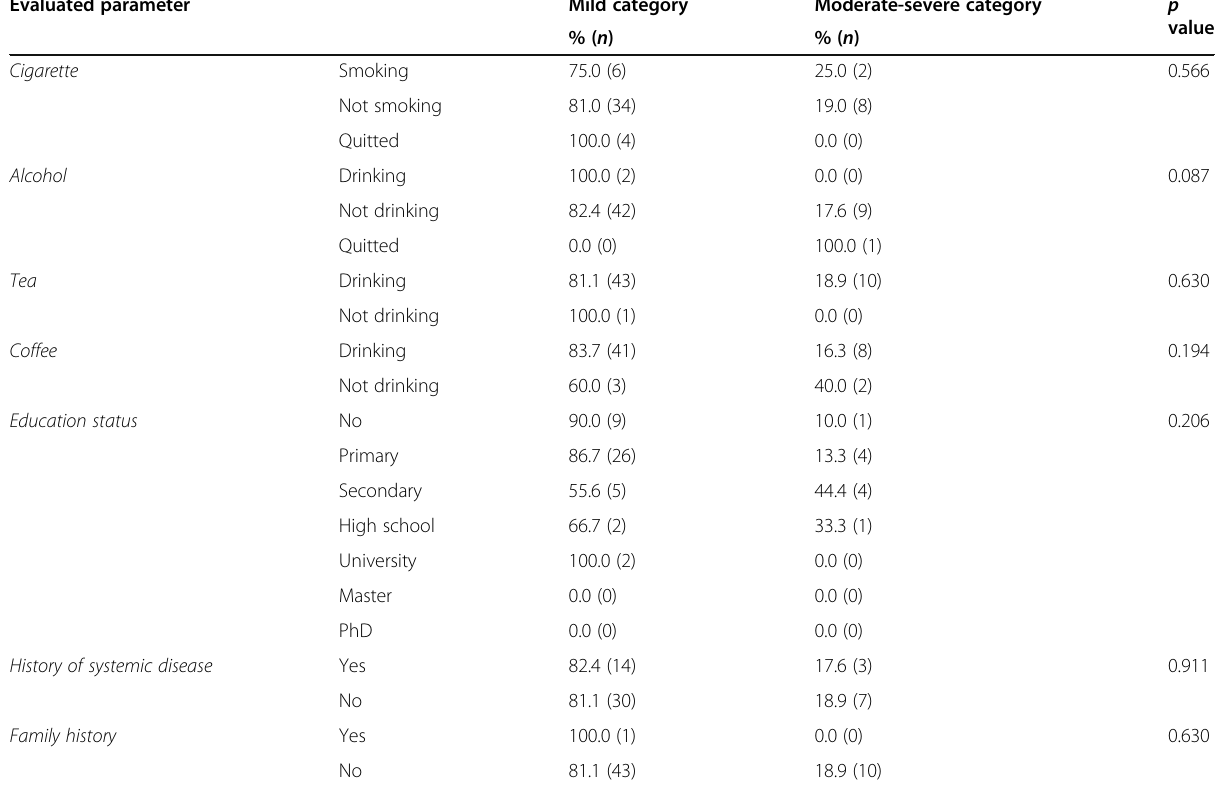
Table 1 Data of CCHF cases on their smoking, alcohol, tea and coffee habits, education levels, and family histories about systemic diseases and dizziness Evaluated parameter Mild category Moderate-severe